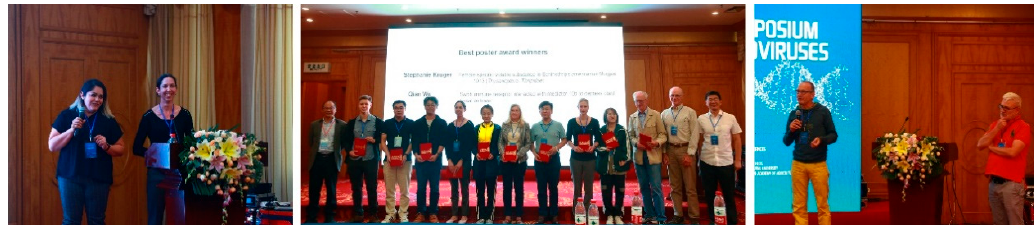
Figure 4. Highlights, best talk awards and best poster awards of this conference.